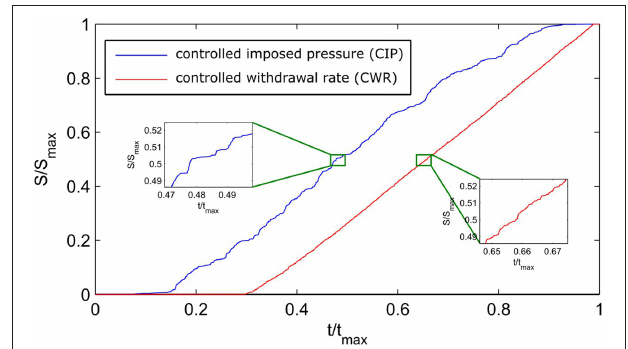
FIGURE 4 | Temporal growth of the air saturation measured from the area of the invading air phase (same model shown in Figure 3 ). Time and saturation are normalized by their final values, t max and S max , respectively. The blue curve (top) shows the data for the controlled imposed pressure (CIP) boundary condition, whereas the red one (bottom) is for the controlled withdrawal rate (CWR). As expected, the later shows a rather constant growth rate, set from the external syringe pump. For the CIP case, we see a much different scenario, with intervals of relative stagnation being followed by periods of sudden area growth in an intermittent manner. The zoomed-in insets emphasize this